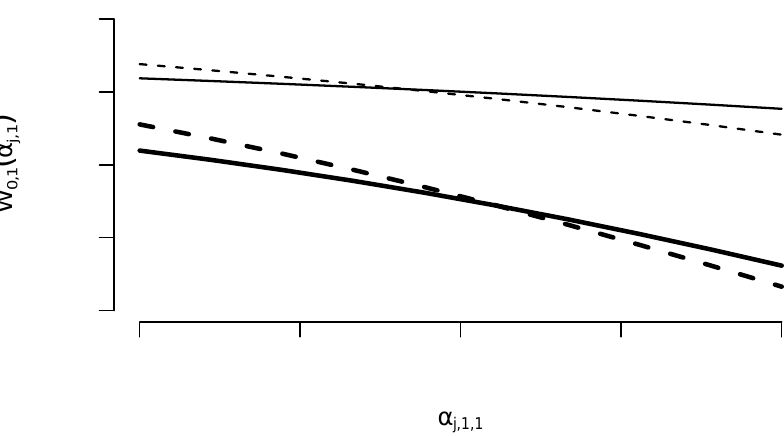
Figure 2. Shifts of the demand curves by increasing investment horizon T . Buyer’s demand with investment horizon T = 1 (dashed) and T = 2 (solid). Thinner lines correspond to the case capital costs r = 5% and probability of issuer’s default p t = p = 0; thicker lines correspond to capital costs r = 5% and probability of issuer’s default p t = p = 0.05 for σ F = 0.1. The x -axis shows α j ,1,1 , the buyer’s position in the put option on the rainfall in Changde during May ( CR May ,1 ) with strike K = 100; the y -axis shows W 0,1 ( α j ,1 ) , the price our representative buyer is willing to pay for such an option, where α j ,1 = ( α j ,1,1 , α j ,1,2 ) (cid:62) and while α j ,1,2 , the position in the other put option on the rainfall in Enshi during May ( CR May ,2 ) is kept constant. Table 4. Put option prices on cumulative rainfall in Changde and Enshi under different market scenarios. Put on CR May ,1 Put on CR May Scenarios